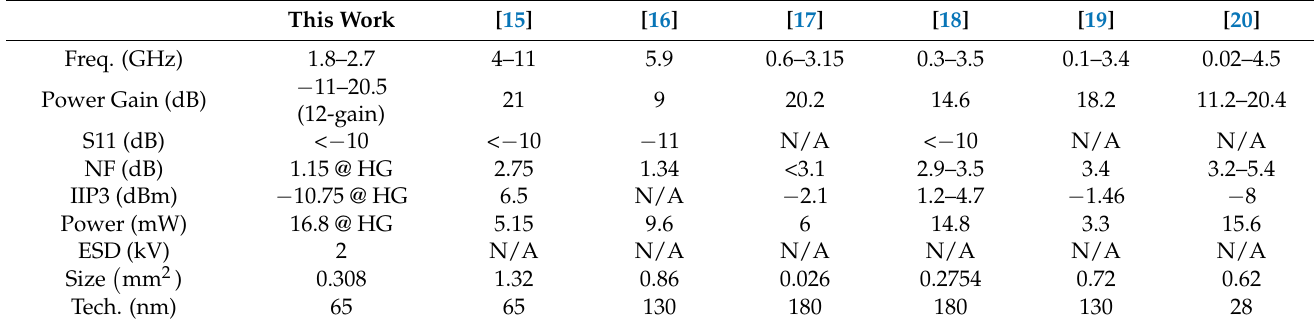
Table 7. Performance summary and comparison to conventional